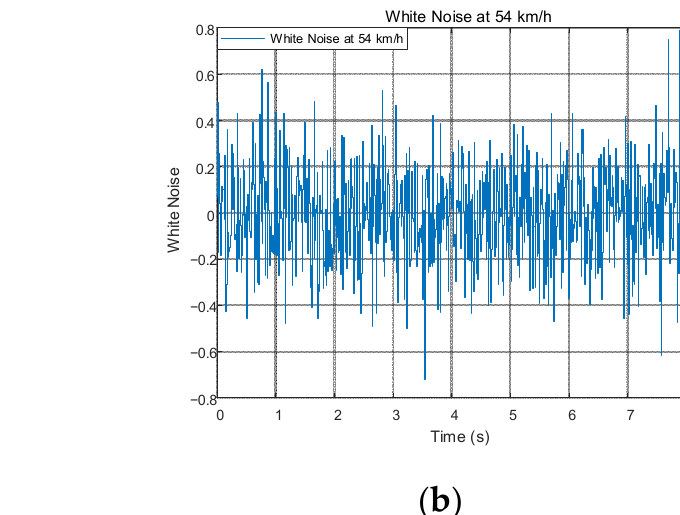
Figure 12. ( a ) Comparison of trajectories at 36 km/h; ( b ) comparison of tracking error at 54 km/h. The comparisons of simulations with different speeds in the presence of uncertainty are shown in Figure 13. Comparison of the tracking error of the ST algorithm at different speeds Comparison of the trajectory of the ST algorithm at different speeds Ideal Trajectory